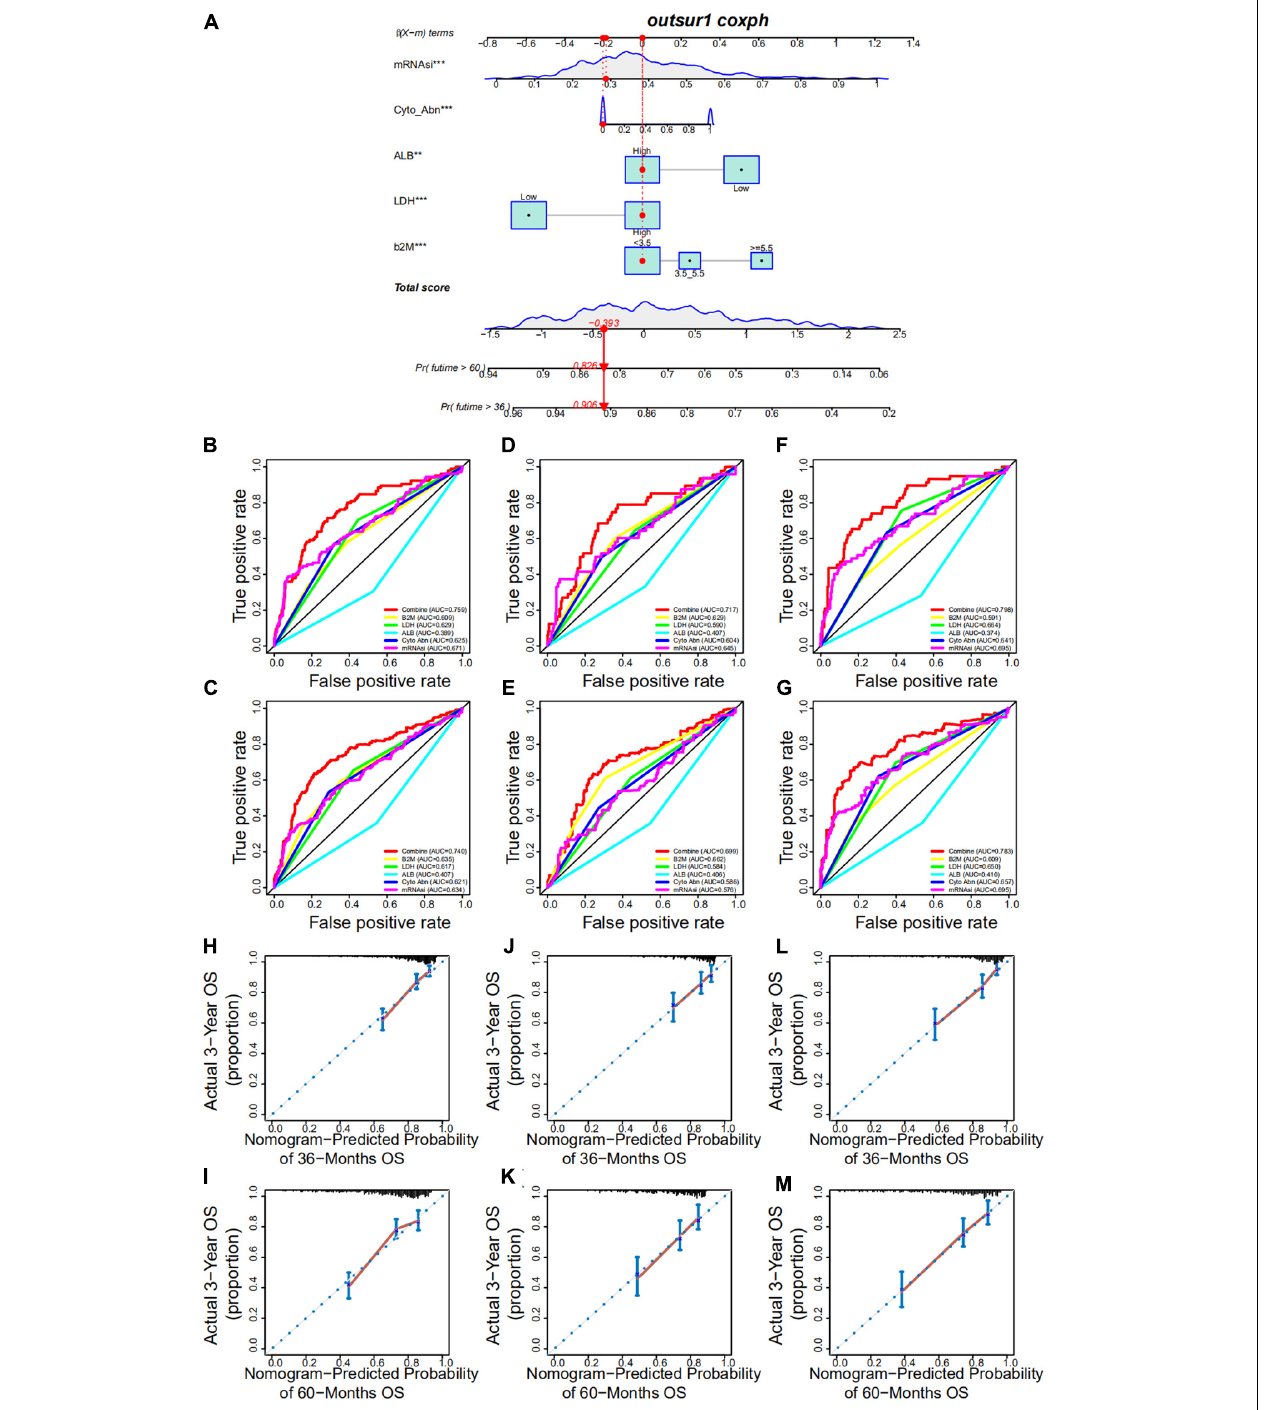
FIGURE 9 | Development and validation of a nomogram. (A) A nomogram combining mRNAsi and other clinicopathologic covariates. (B,C) Receiver operating characteristic (ROC) curve to evaluate the accuracy of the 3-year (B) and 5-year (C) OS nomogram in the training cohort. (D,E) ROC curve to evaluate the accuracy of the 3-year (D) and 5-year (E) OS nomogram in test set 1. (F,G) ROC curve to evaluate the accuracy of the 3-year (F) and 5-year (G) OS nomogram in test set 2. (H,I) Calibration plots indicating that nomogram-predicted 3- (H) and 5-year (I) survival probabilities of the training set corresponded closely to the observed proportions. (J,K) Calibration plots indicating that nomogram-predicted 3- (J) and 5-year (K) survival probabilities of test set 1 corresponded closely to the observed proportions. (L,M) Calibration plots indicating that nomogram-predicted 3- (L) and 5-year (M) survival probabilities of test set 2 corresponded closely to the observed